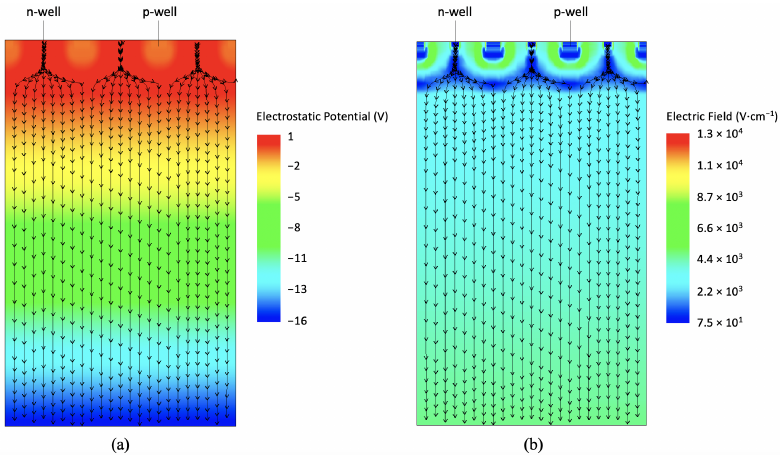
Figure 5. Electrostatic potential map ( a ) and electric field map ( b ) for a group of three ARCADIA microstrip sensors at V back = V dpl . The electric field lines are plotted on top of both